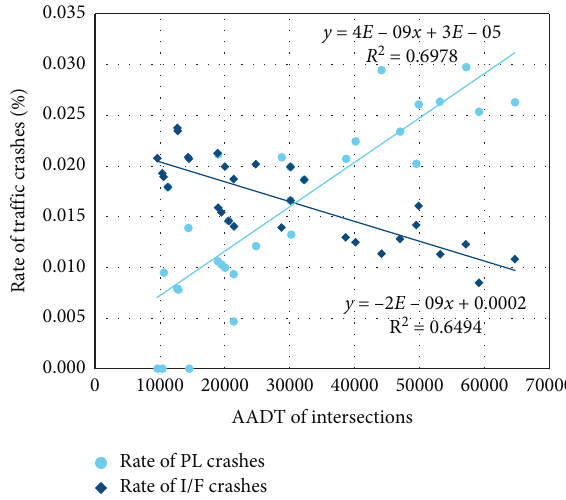
Figure 6: The relationship between the AADTof intersections and the rate of property-loss/injury-or-fatal